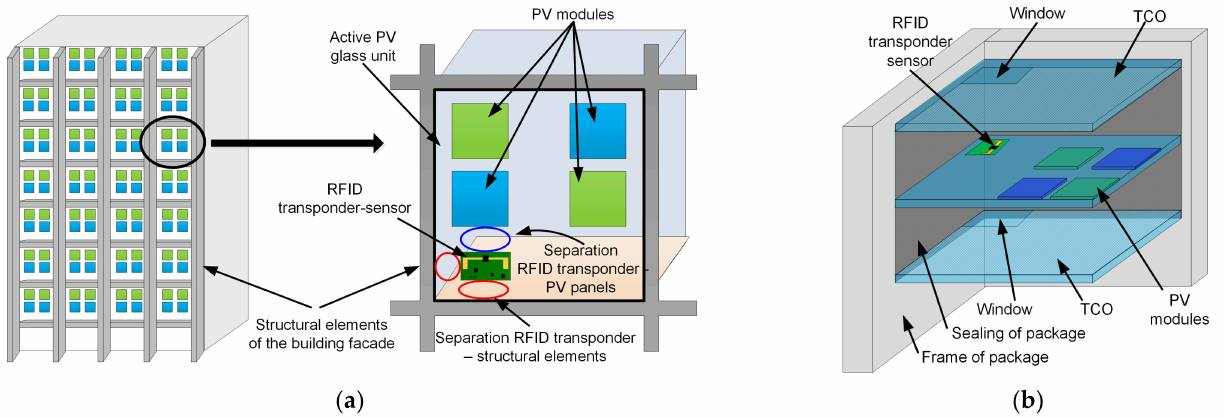
Figure 1. Active glazing unit in modern multi-storey buildings: ( a ) Spatial separation between RFID sensor and construction elements; ( b ) Idea of using window in the TCO or heating layer for delivering system electromagnetic field to antenna of RFID